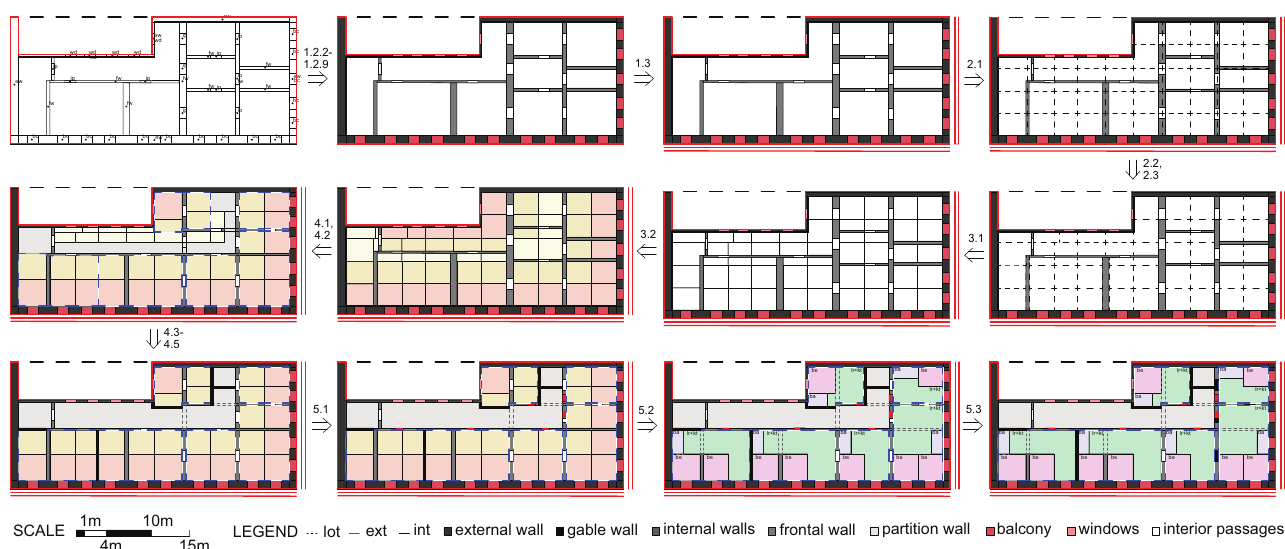
Figure 13. Derivation process for the case study building